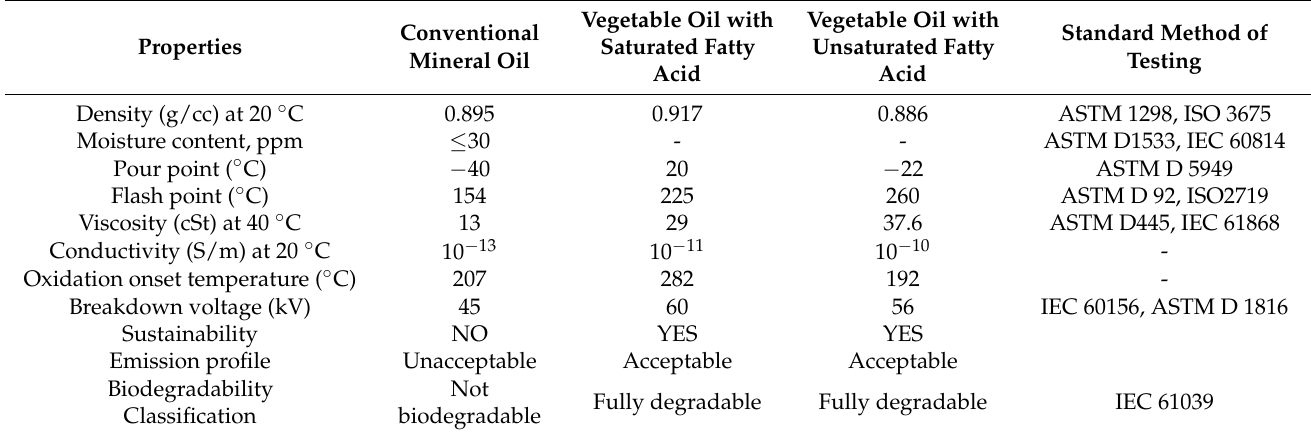
Table 1. Some properties of mineral oils and vegetable-based liquid